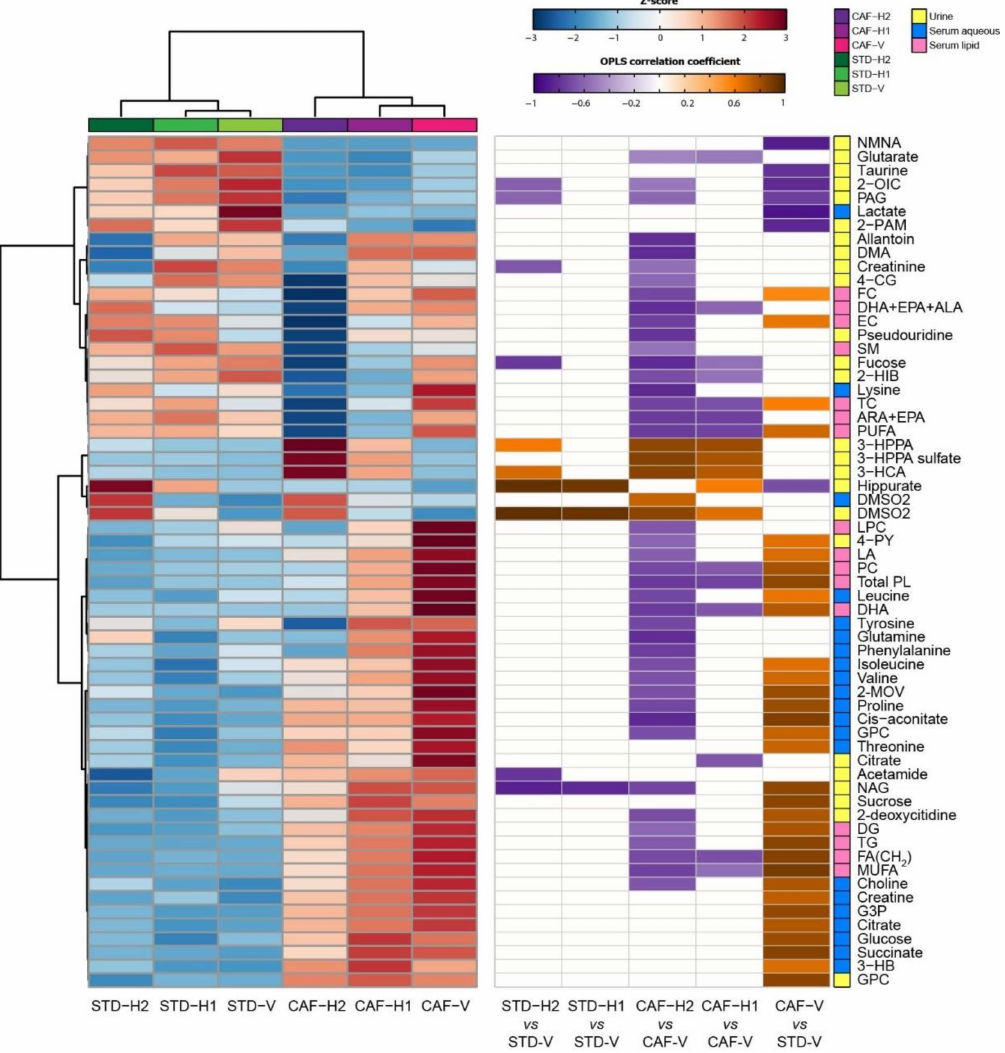
Figure 5. Summary of the diet- and hesperidin-induced metabolic alterations identified by the OPLS-DA models. (Left) Dendrogram and metabolite heatmap displaying the group averages. A metabolite z-transformation was performed on the intensity of each metabolite across samples. Metabolites and groups were clustered by Euclidean distance and Ward linkage hierarchical clustering. (Right) Significant OPLS-DA correlation coe ffi cients associated with the indicated pairwise models. 2-HIB, 2-hydroxyisobutyrate, 2-MOV; 3-methyl-2-oxovalerate; 2-OIC; 2-oxoisocaproate; 2-PAM, 2-phenylacetamide; 3-HCA, 3-hydroxycinnamic acid; 3-HPPA, 3-hydroxhyphenylpropionic